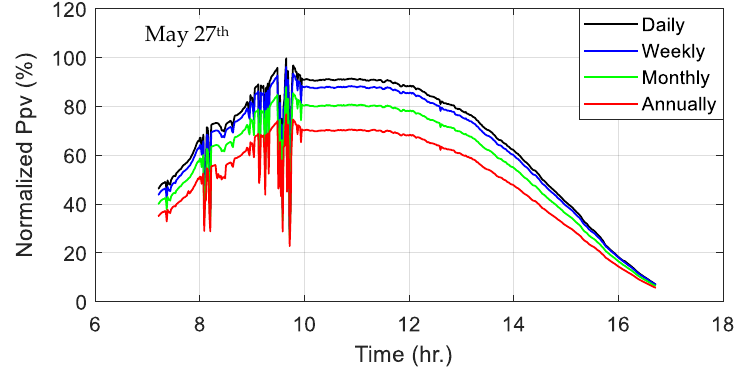
Figure 12. Actual PV data under different cleaning periods (partly cloudy day).